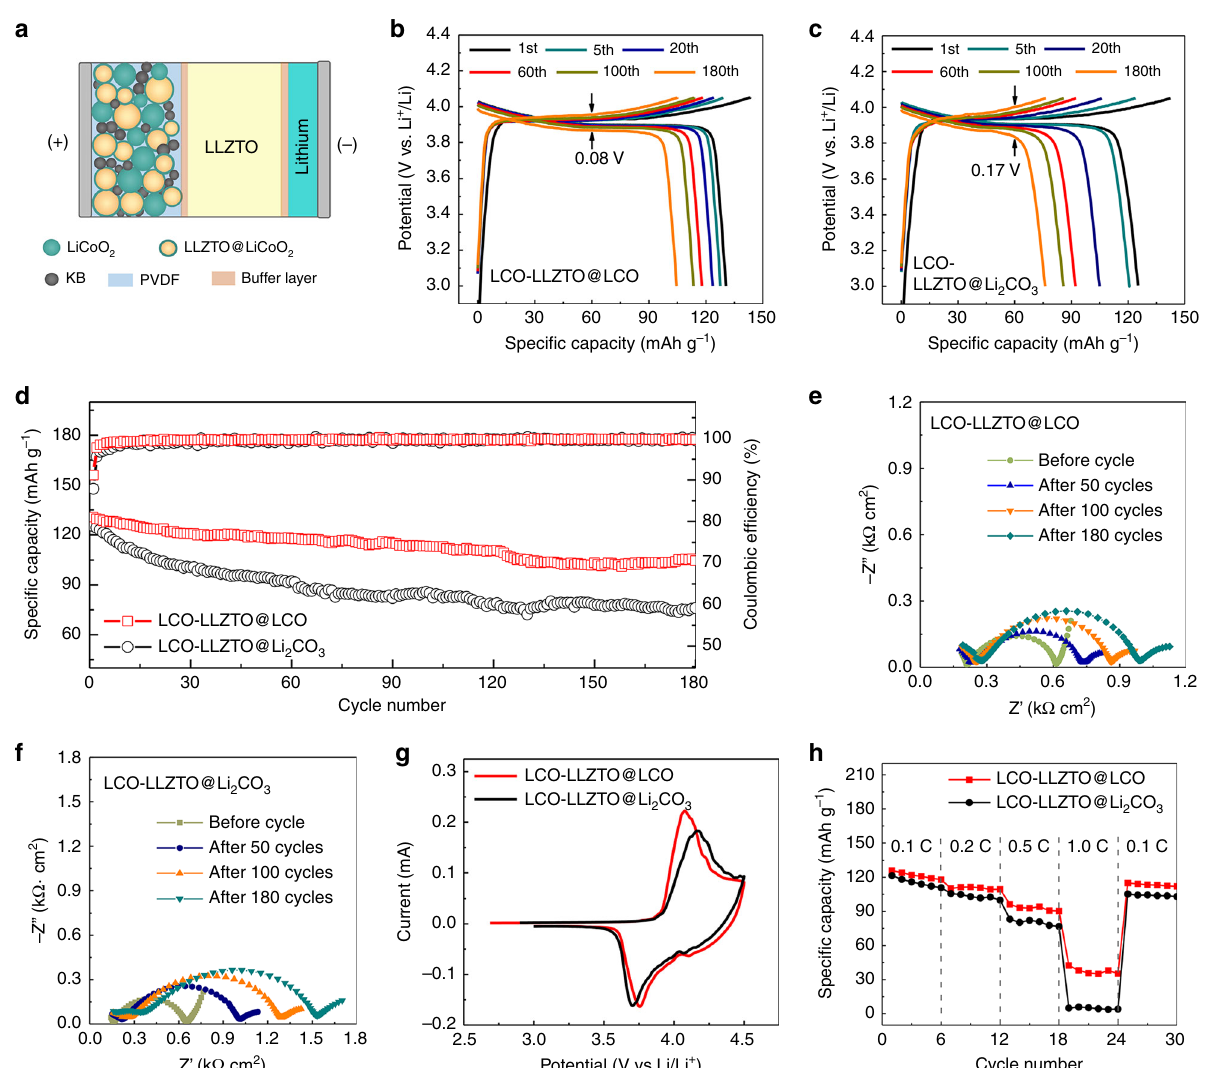
Fig. 5 Electrochemical performance of the LLZTO-based SSBs. a Schematic illustration of the LLZTO-based SSB. The buffer layer was formed by dissolving 10 wt% of lithium tri fl uoromethanesulfonyl (LiTFSI) in succinonitrile (SN), and polyacrylonitrile (PAN) was added to enhance fi lm-forming property. b , c Discharge/charge curves of the SSBs with an LCO-LLZTO@LCO and LCO-LLZTO@Li 2 CO 3 cathode, separately. d Cycling performance of the SSBs with an LCO-LLZTO@LCO and LCO-LLZTO@Li 2 CO 3 cathode, separately. e , f EIS of the SSBs with a LCO-LLZTO@LCO and LCO-LLZTO@Li 2 CO 3 cathode, separately. g CVs of the SSBs with an LCO-LLZTO@LCO and LCO-LLZTO@Li 2 CO 3 cathode, separately. h Rate capability of the SSBs with an LCO- LLZTO@LCO and LCO-LLZTO@Li 2 CO 3 cathode, separately. All tests were performed at room LLZTO@Li 2 CO 3 is added, large-span transport channels for lithium ions are formed around LLZTO@Li 2 CO 3 particles, which can quickly transport lithium ions deeper into the LCO-LLZTO@ Li 2 CO 3 composite cathode. But, the presence of Li 2 CO 3 on the surface of LLZTO is like sludge in the channels. Lithium ions can